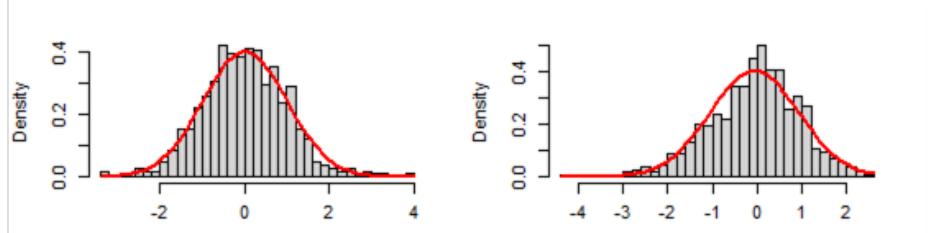
Figure 4. Standardized residuals for the crude oil and natural gas datasets.